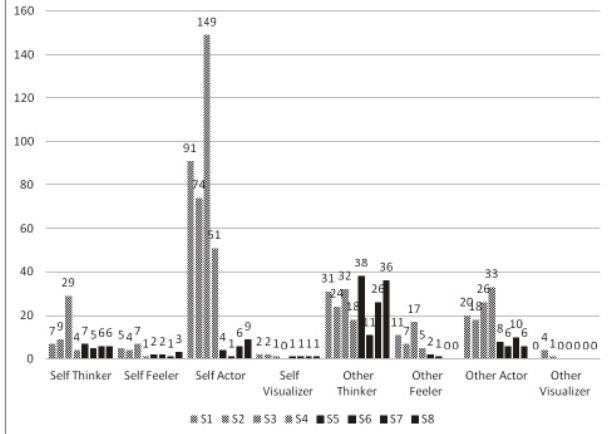
Figure 7. Frequencies of different SPT roles adopted by each individual summed across all time